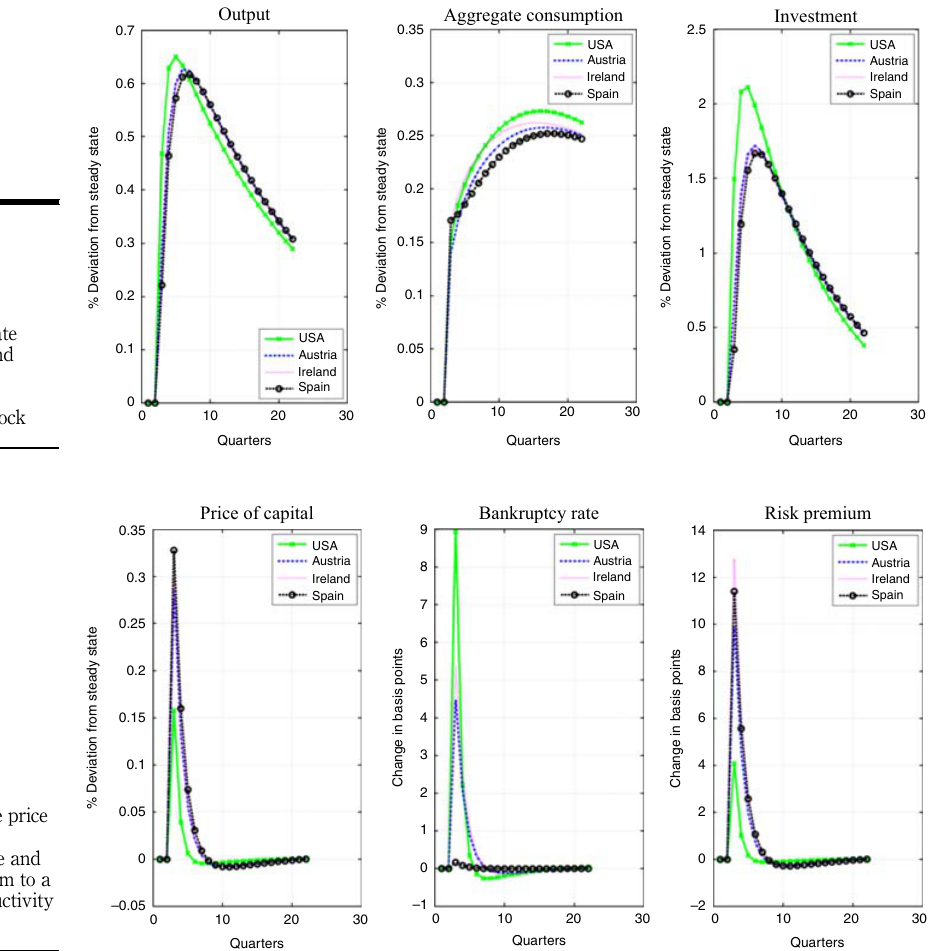
Figure 4. Response of the price of capital, the bankruptcy rate and the risk premium to a 1 percent productivity shock